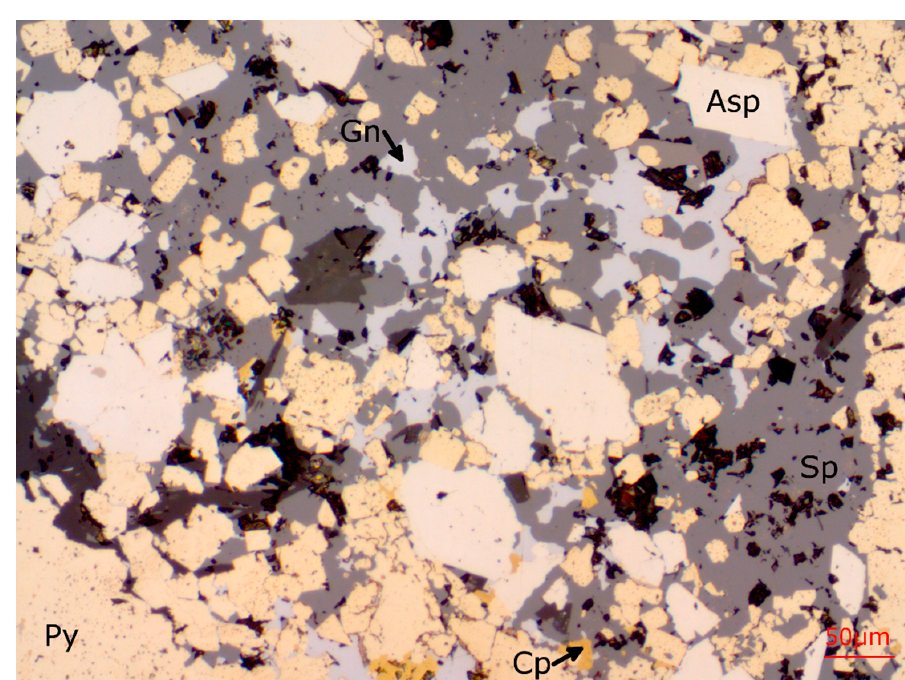
Figure 9. Reflected light photomicrograph from the L4-14-132.0 polished thin section. Relatively large subhedral to euhedral Asp grains and finer subhedral Py grains are commonly in contact at grain boundaries with interstitial Sp. Sphalerite, Cp, and Gn occur primarily as interstitial phases between the grains of Asp and Py.